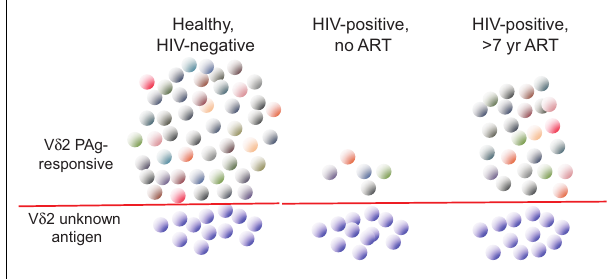
FIGURE 2 |The impact of HIV infection on circulatingV γ 9V δ 2T cells . The characteristics of circulatingV γ 9V δ 2T cells (abbreviatedV δ 2) are summarized for healthy, HIV-uninfected, and HIV-infected patients without antiretroviral therapy (ART) or after > 7years of ART. Individual cell clones are designated by colored symbols. Below the red line, we show the population ofV γ 9V δ 2T cells that do not respond to phosphoantigen (PAg) and remain at roughly equal numbers irrespective of infection or treatment. Without ART, HIV infection drives down the number andTCR complexity of PAg-responsiveV γ 9V δ 2 (above the red line). After prolonged ART,TCR complexity recovers in the PAg-responding population (indicated by different colors) but the numbers and functions remain below uninfected controls. Adapted from Ref. (50, 70,